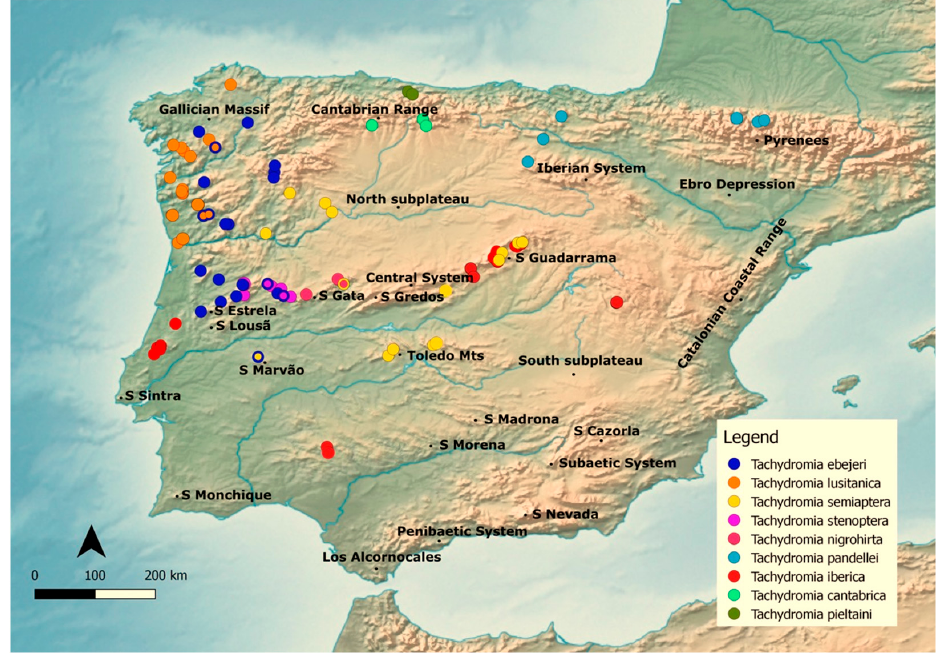
Figure 1. Topography of the Iberian Peninsula. The dots represent recorded species distribution. All localities mentioned in this work are indicated on the map. Adapted from Gonçalves et al., 2021.